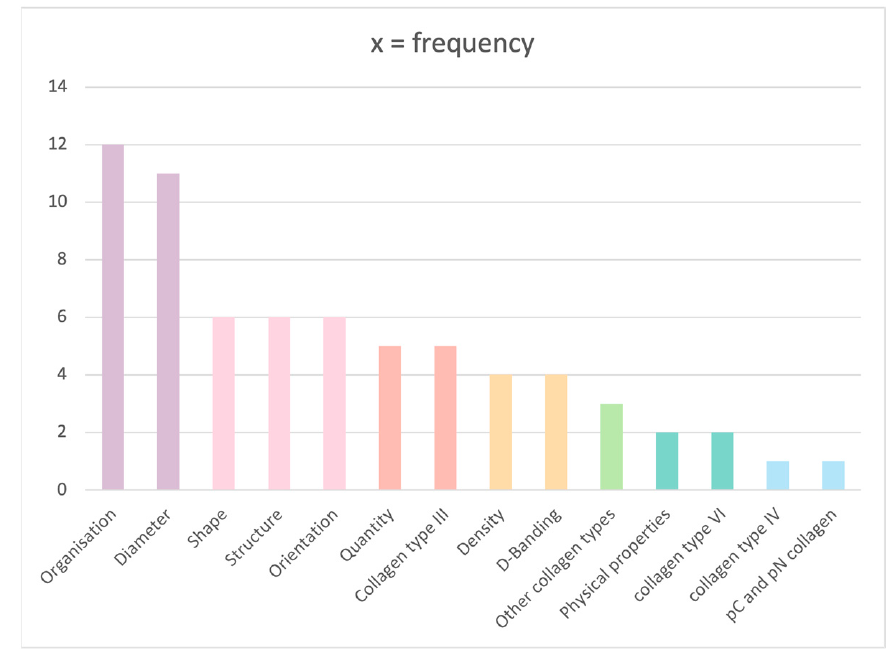
Figure 4. Number of studies covering each parameter.